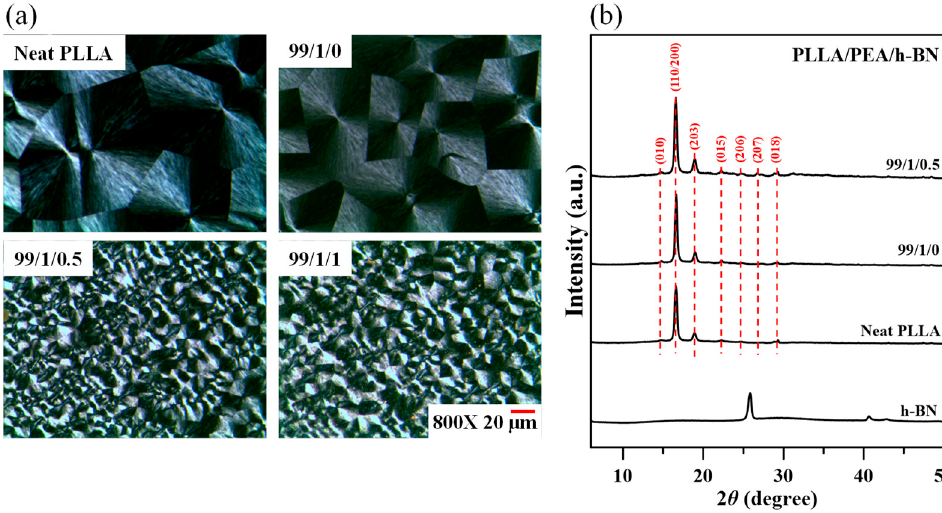
Figure 2. ( a ) Polarized optical microscopy (POM) images of neat PLLA and PLLA/PEA/h-BN composites crystallized at 110 °C; ( b ) Wide-angle X-ray diffraction (WAXD) results of neat PLLA and PLLA/PEA/h-BN composites crystallized at 110 °C.